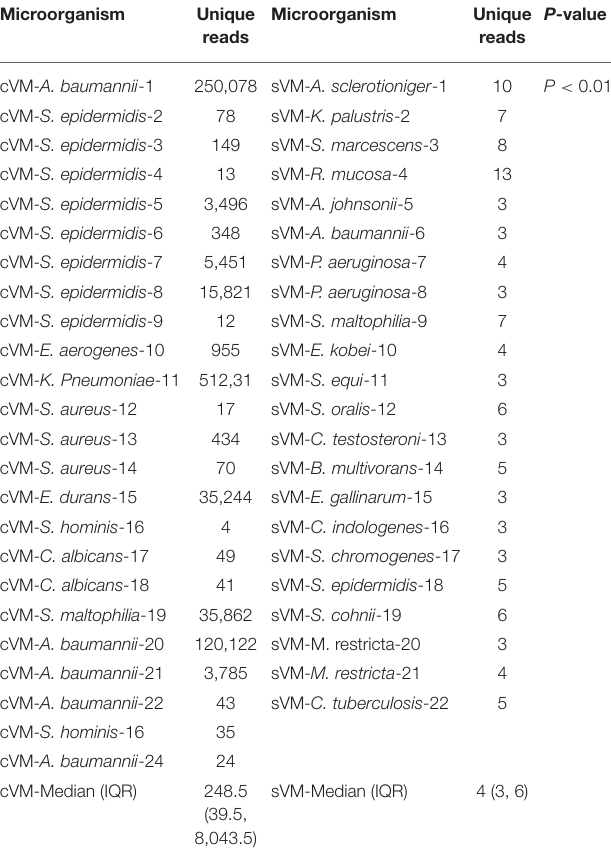
TABLE 2 | The results of mNGS and conventional microbiological testing. TABLE 3 | Unique reads for pathogens detected by